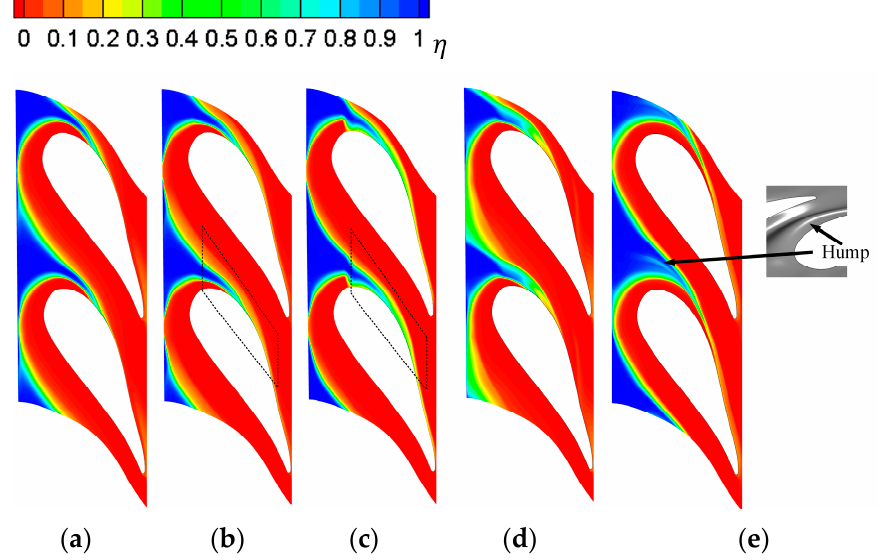
Figure 10. Film cooling effectiveness distributions on the endwall. ( a ) Initial contour. ( b ) Case 1. ( c ) Case 2. ( d ) Case 3. ( e ) Case 4. ( c ) Case 2. ( d ) Case 3. ( e ) Case